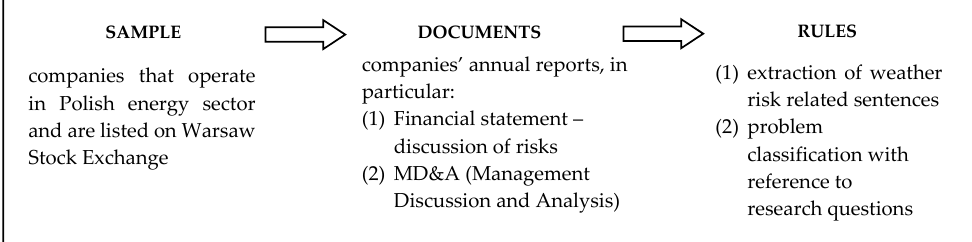
Table 1. Companies included in the research sample.